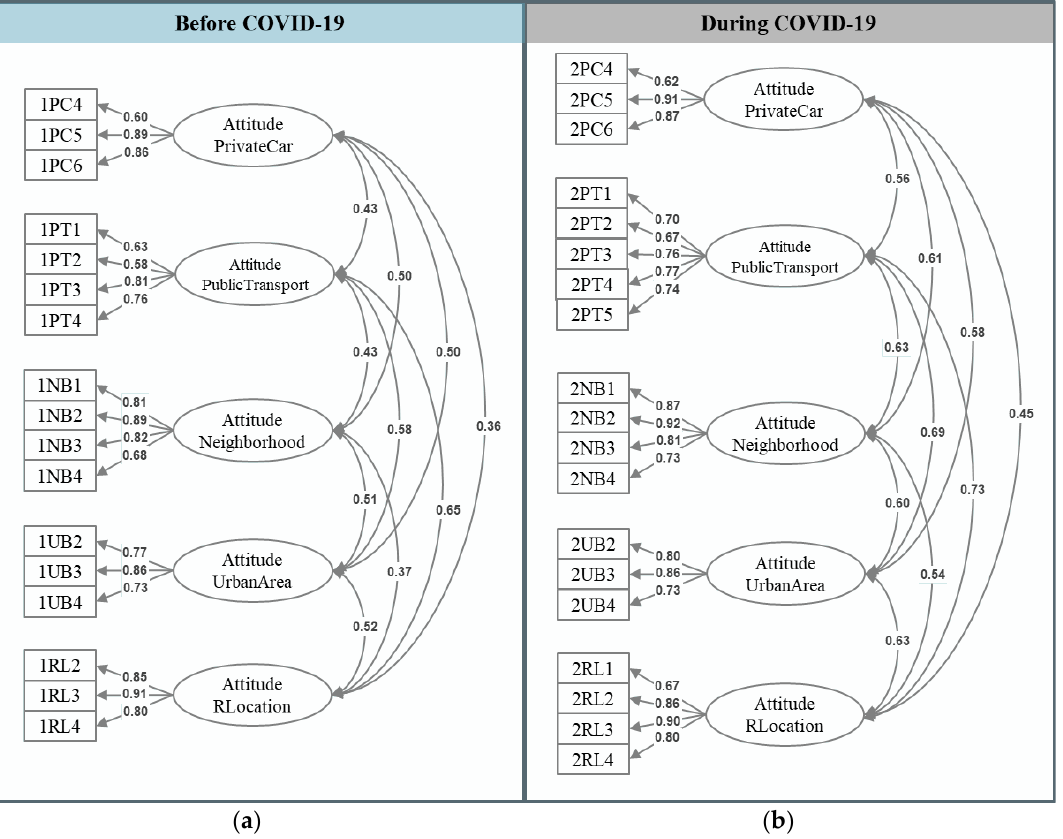
Figure 3. Confirmatory factor analysis results for ( a ) before COVID-19; ( b ) during COVID-19.